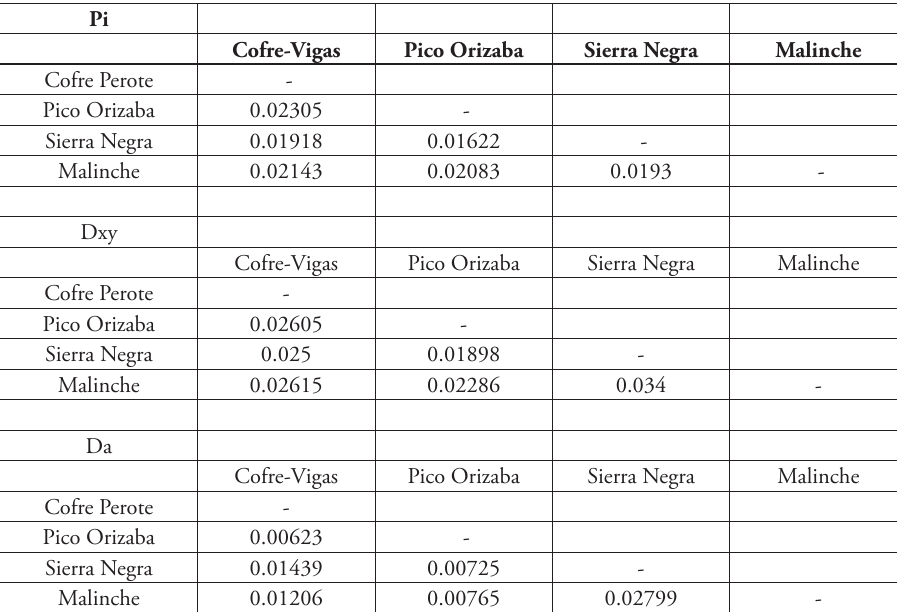
Table 1. Nucleotide diversity: (Pi, Dxy and Da) between G. pierai and G.barrerai . Pi Cofre-Vigas Pico Orizaba